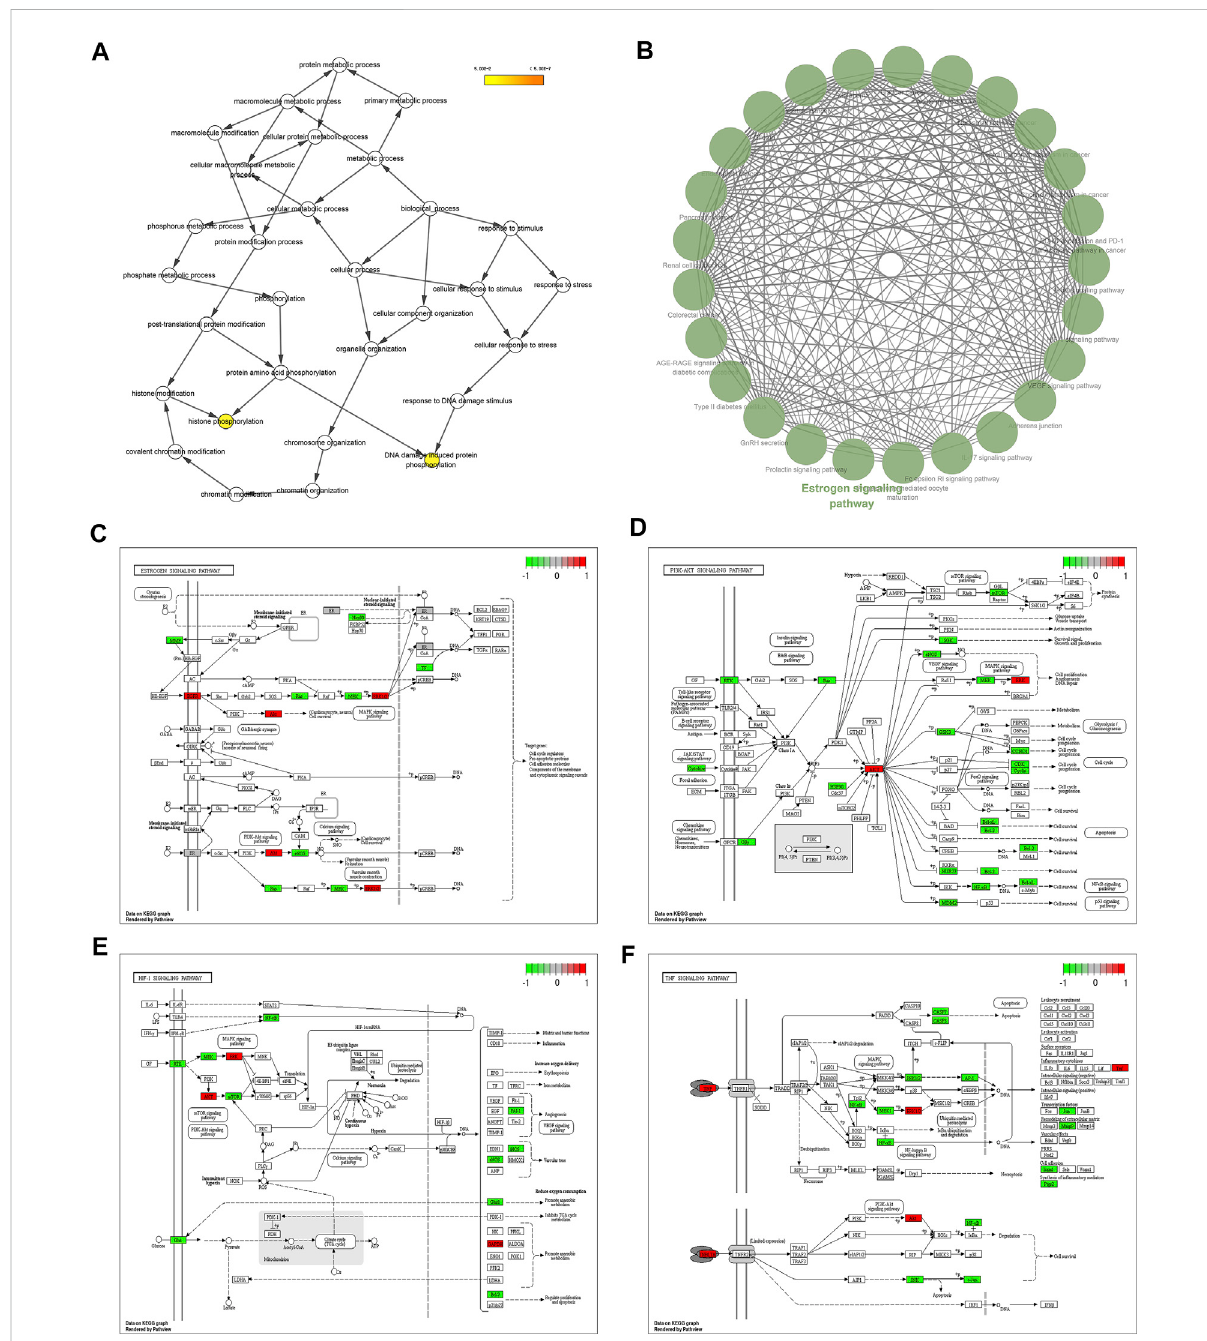
FIGURE 6 Analyses ofGO andKEGGenrichmentfor core proteins ( p -value ≤ 0.05). (A) GO enrichmentforcore proteins usingBiNGO. Biological process, cellular component, and molecular function are all included. (B) KEGG pathway enrichment of the core proteins using ClueGO. (C) Estrogen signaling pathway. (D) PI3K-Akt signaling pathway. (E) HIF-1 signaling pathway. (F) TNF signaling pathway. The green rectangle represents the CCMM-MI common-target associated with the main KEGG signaling pathways. The red rectangle represents the key targets of CCMM on